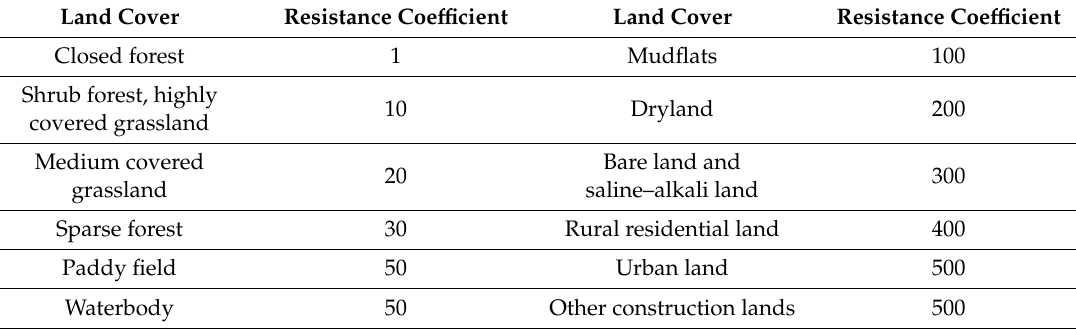
Table 8. Land cover resistance for biodiversity and recreation ESP